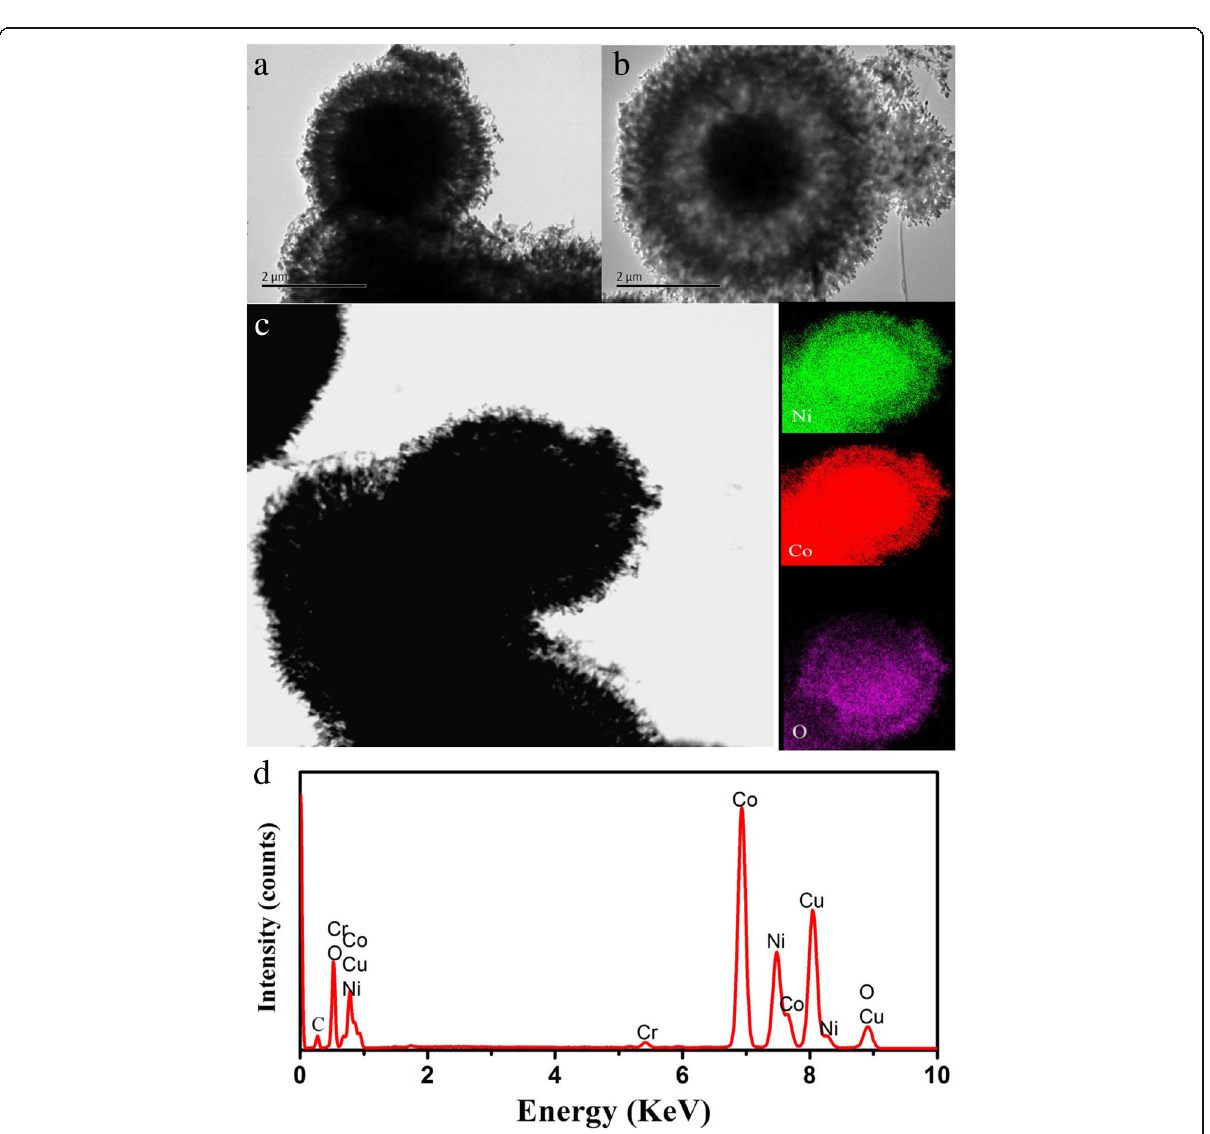
Fig. 3 The TEM images ( a – c ) and EDS image ( d ) of NiO/NiCo 2 O 4 mixtures with the annealing temperature of 650